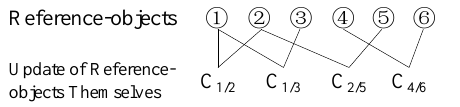
Fig. 2 An Example of Reference-objects Self-update